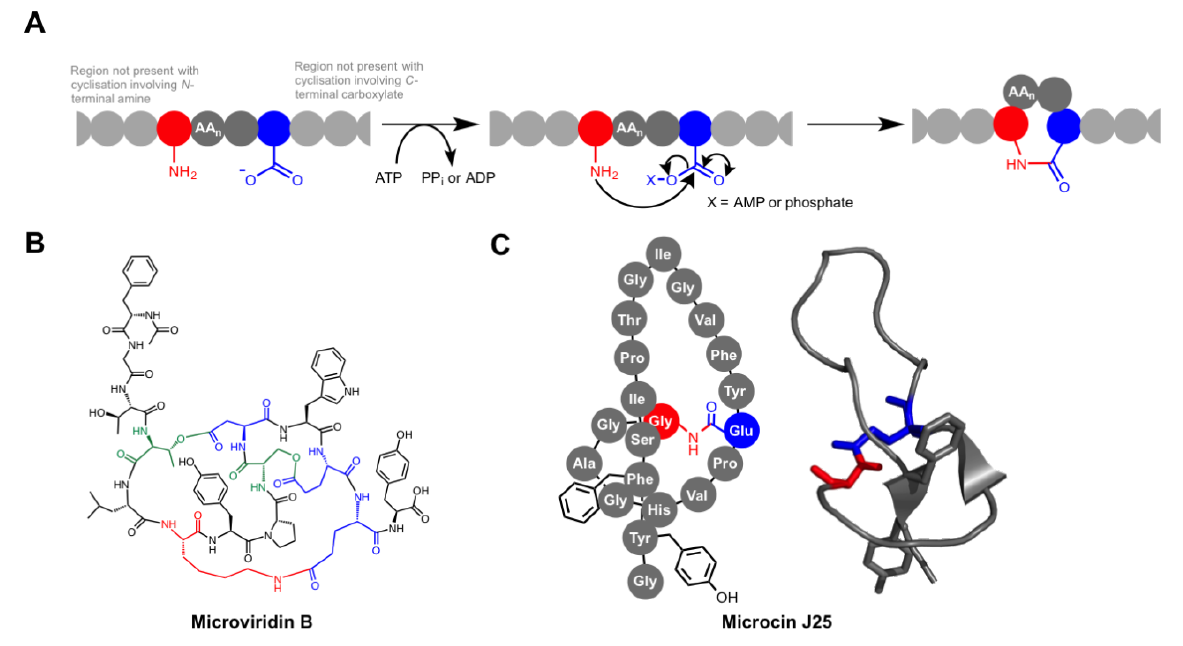
Figure 7: ATP-dependent macrocyclisation. A) General mechanism for ATP-dependent macrolactonisation or macrolactamisation in RiPPs. B) Structure of microviridin B, where the nucleophilic residues involved in the formation of cyclic esters are coloured green. C) Illustration of microcin J25 alongside a solution NMR structure [93] of this molecule (PDB: 1PP5). The Phe19 and Tyr20 side chains are shown in both structures to illus- trate how the lasso peptide is conformationally restricted following cyclisation.